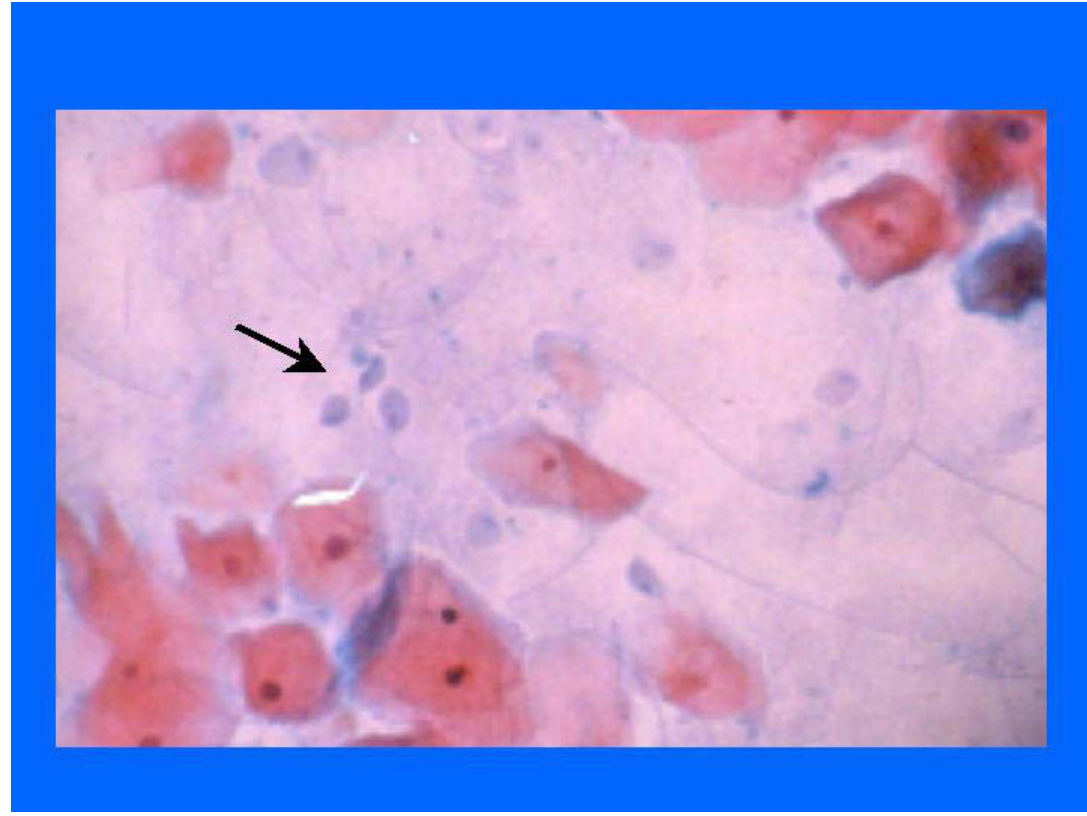
FIGURE 1 . Papanicolaou smear showing many superficial and intermediate cervical squamous cells and several trichomonads. Three T. vaginalis organisms are seen almost in the center (at arrow) of the figure. They are oval- to pear-shaped, stain blue, and contain a small